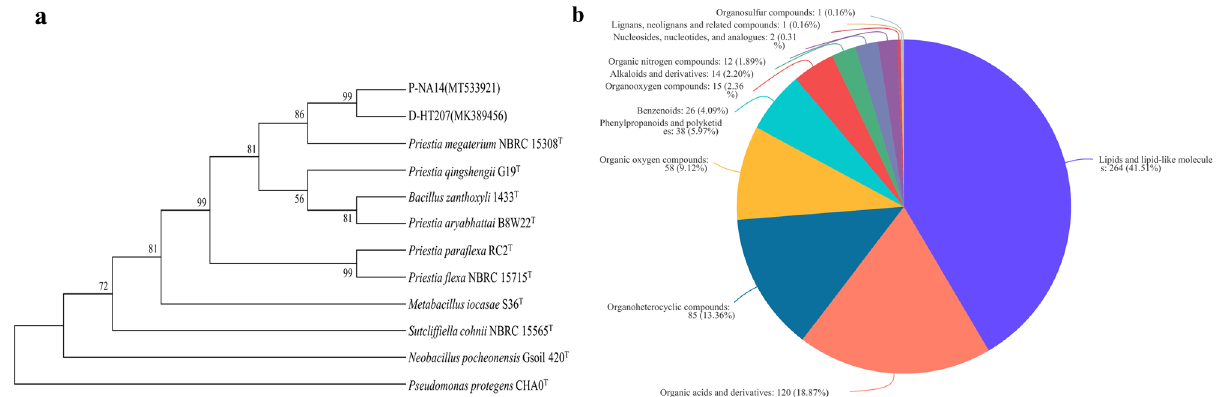
Figure 1. ( a ) The phylogenetic tree of P. megaterium P-NA14 and P. megaterium D-HT207 was identified in this study. The identification showed that P. megaterium P-NA14 and P. megaterium D-HT207 belonged to the same species. ( b ) Classification of the identified metabolites annotated using the Metlin